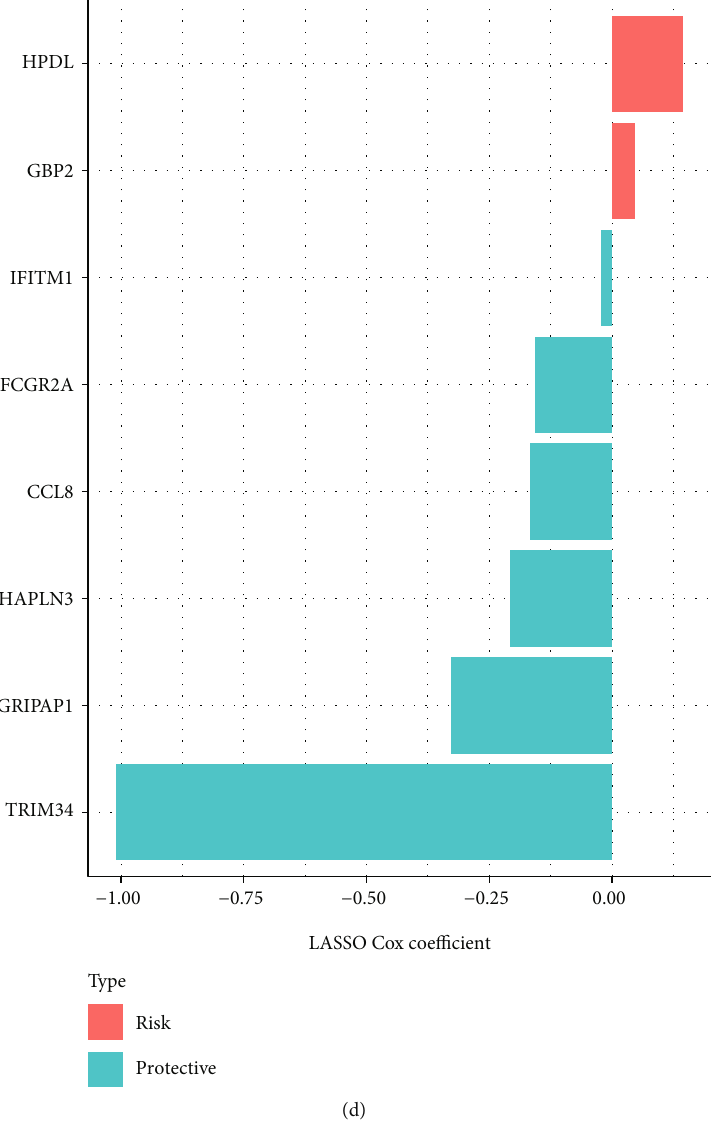
Figure 4: Construction of the PPRS for melanoma patients. (a) 984 prognostic genes were obtained by univariate Cox regression analyses. (b) The changing trajectory of each independent variable. The horizontal axis represents the log value of the independent variable lambda, and the vertical axis represents the coe ffi cient of the independent variable. (c) Con fi dence intervals for each lambda. (d) Distribution of LASSO coe ffi cients of